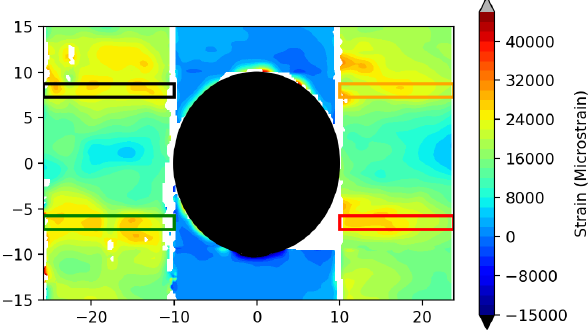
Figure 8: Line slices over hoop strain contour plot at failure. First point of failure in the surface material is indicated by the voids inside the black line slice. Notice also the shear splitting along the tangent to the hole, leaving the center with little load bearing material.